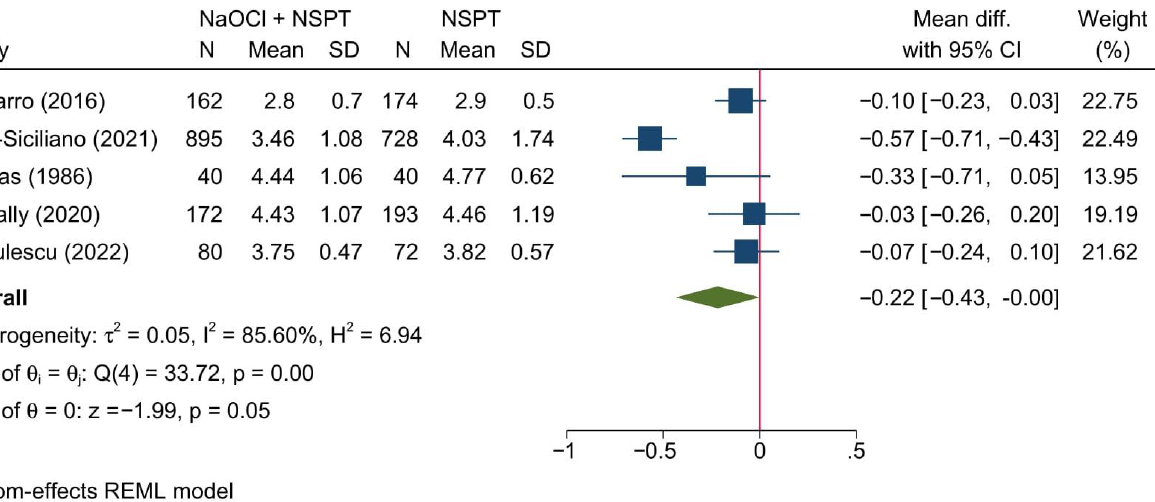
Figure 11. Forest plot showing the comparison between NaOCl + NSPT and NSPT alone regarding probing pocket depth [36,37,39,41,45].